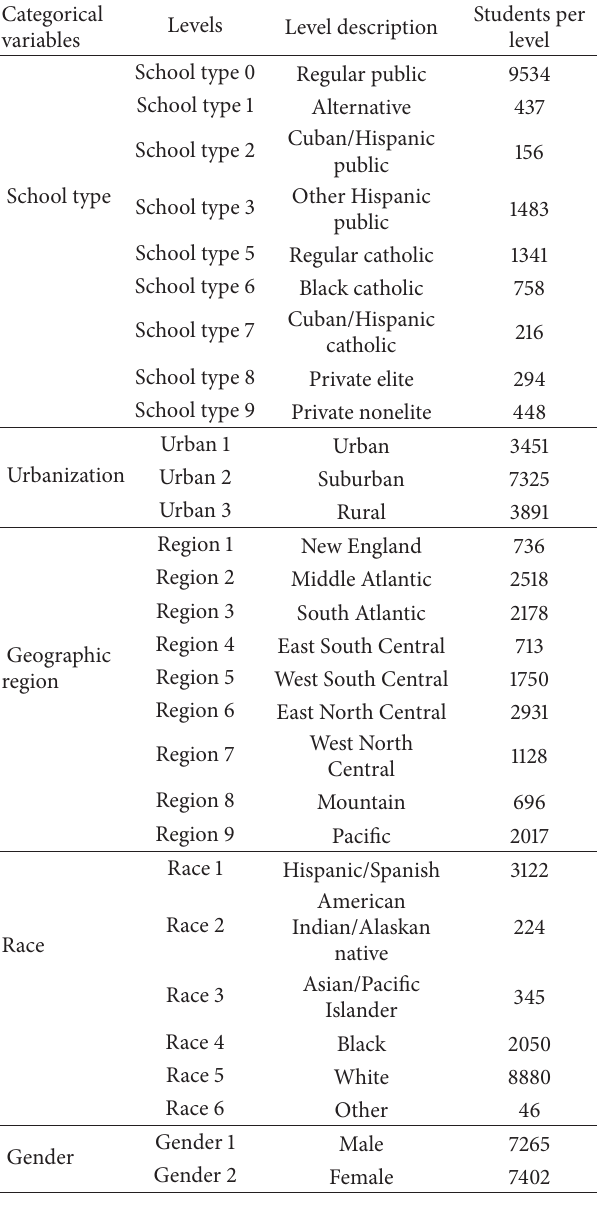
Table 1: Categorical explanatory variable